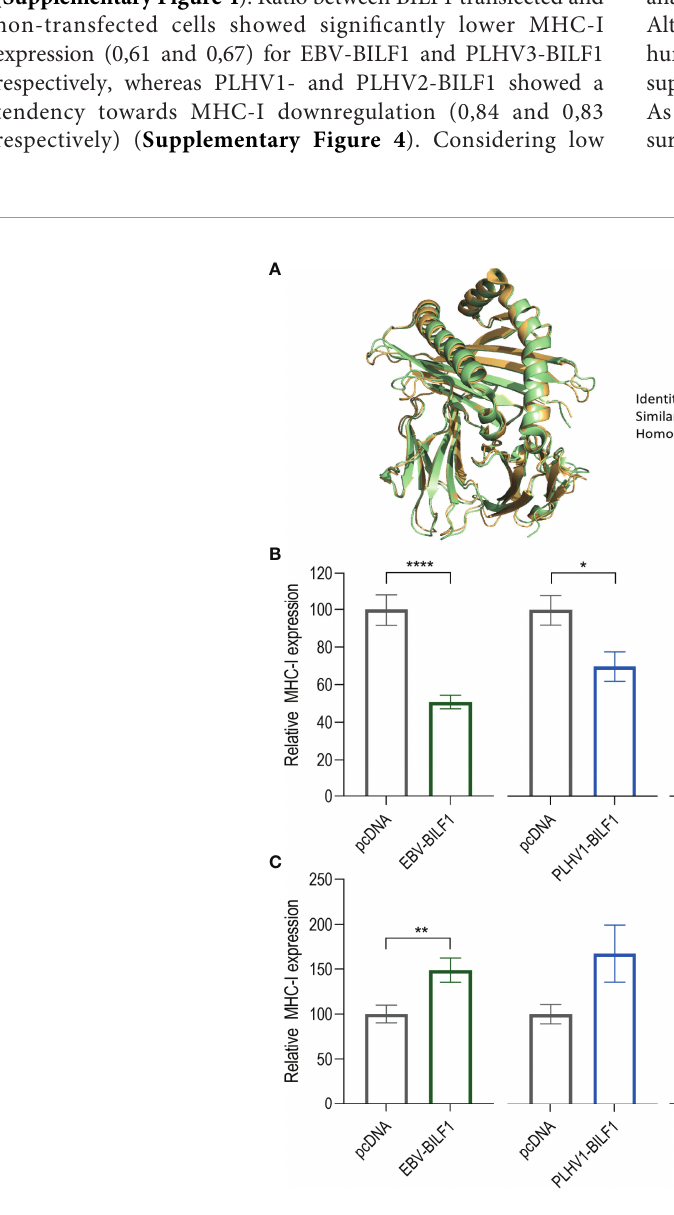
FIGURE 5 | PLHV1-3 BILFs downregulate surface MHC-I molecules. (A) Porcine SLA-I molecule (green) compared to the human HLA-I molecule (orange). The differences between the molecules are marked in red. (B) HEK-293 and (C) PK-15 cells were transfected with FLAG-labelled BILF1 orthologues and stained with rabbit anti-FLAG (receptor labelling) and mouse anti-human HLA class I antibodies. Graphs represent the percentage of surface expressed MHC-I molecules at the surface of 33 BILF1- transfected and 33 non-transfected cells. Statistics were performed by unpaired student t-test using GraphPad Prism. *p – value < 0.05; **p – value < 0.01; ****p – value <